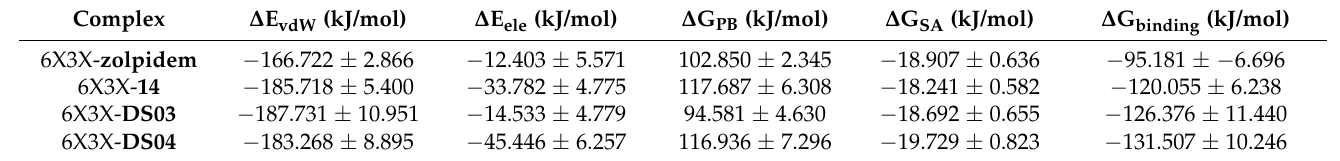
Table 7. The free binding energies of zolpidem, compound 14 , and the newly screened hit compounds ( DS03 and DS04 ) in the human GABA A R (PDB ID: 6X3X).